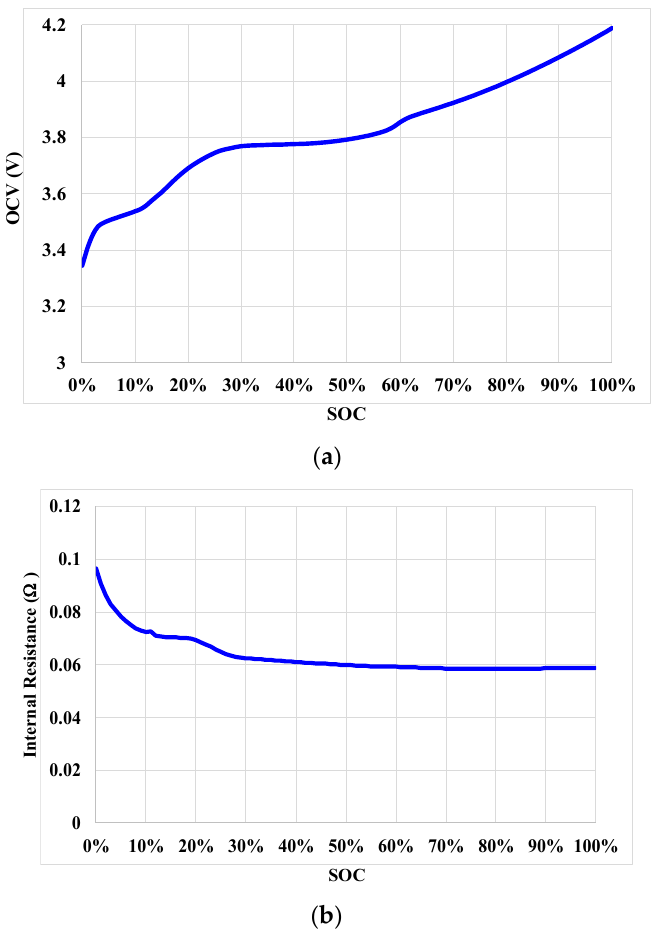
Figure 8. Battery characteristic curve test: ( a ) Curve of OCV vs. SOC, ( b ) curve of internal resistance vs. SOC.